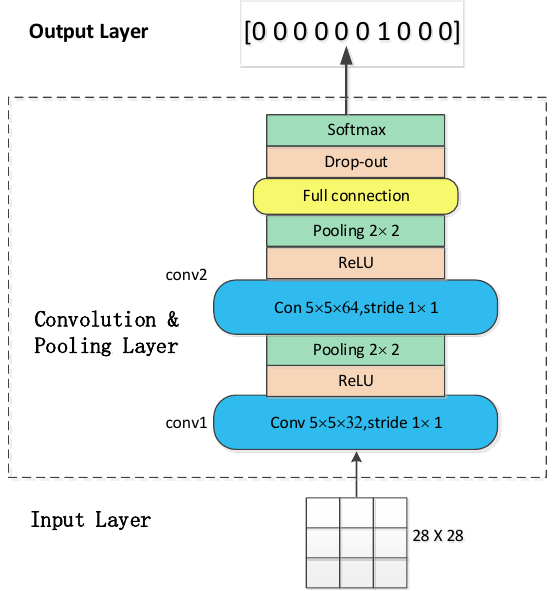
Figure 2. The process of convolutional neural